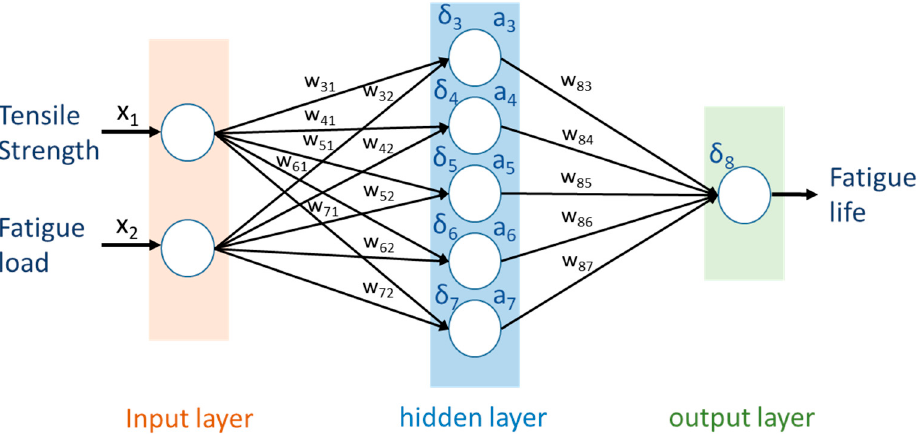
Figure 6. Artificial neural network architecture.